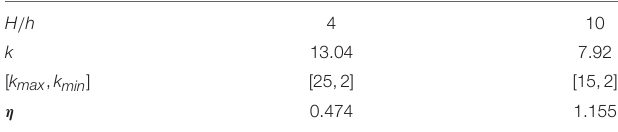
TABLE 3 | The performance gain between the patch method and the standard one (without patch) for the case of Figure 7 estimated using formula (28) with k being the average number of iterations needed for convergence by the patch algorithm over all wave periods ( k max and k min are the maximum and the minimum number of iterations, respectively), α = 3.1740, β = 4,10 and D = 2 (see section 3.2). H /